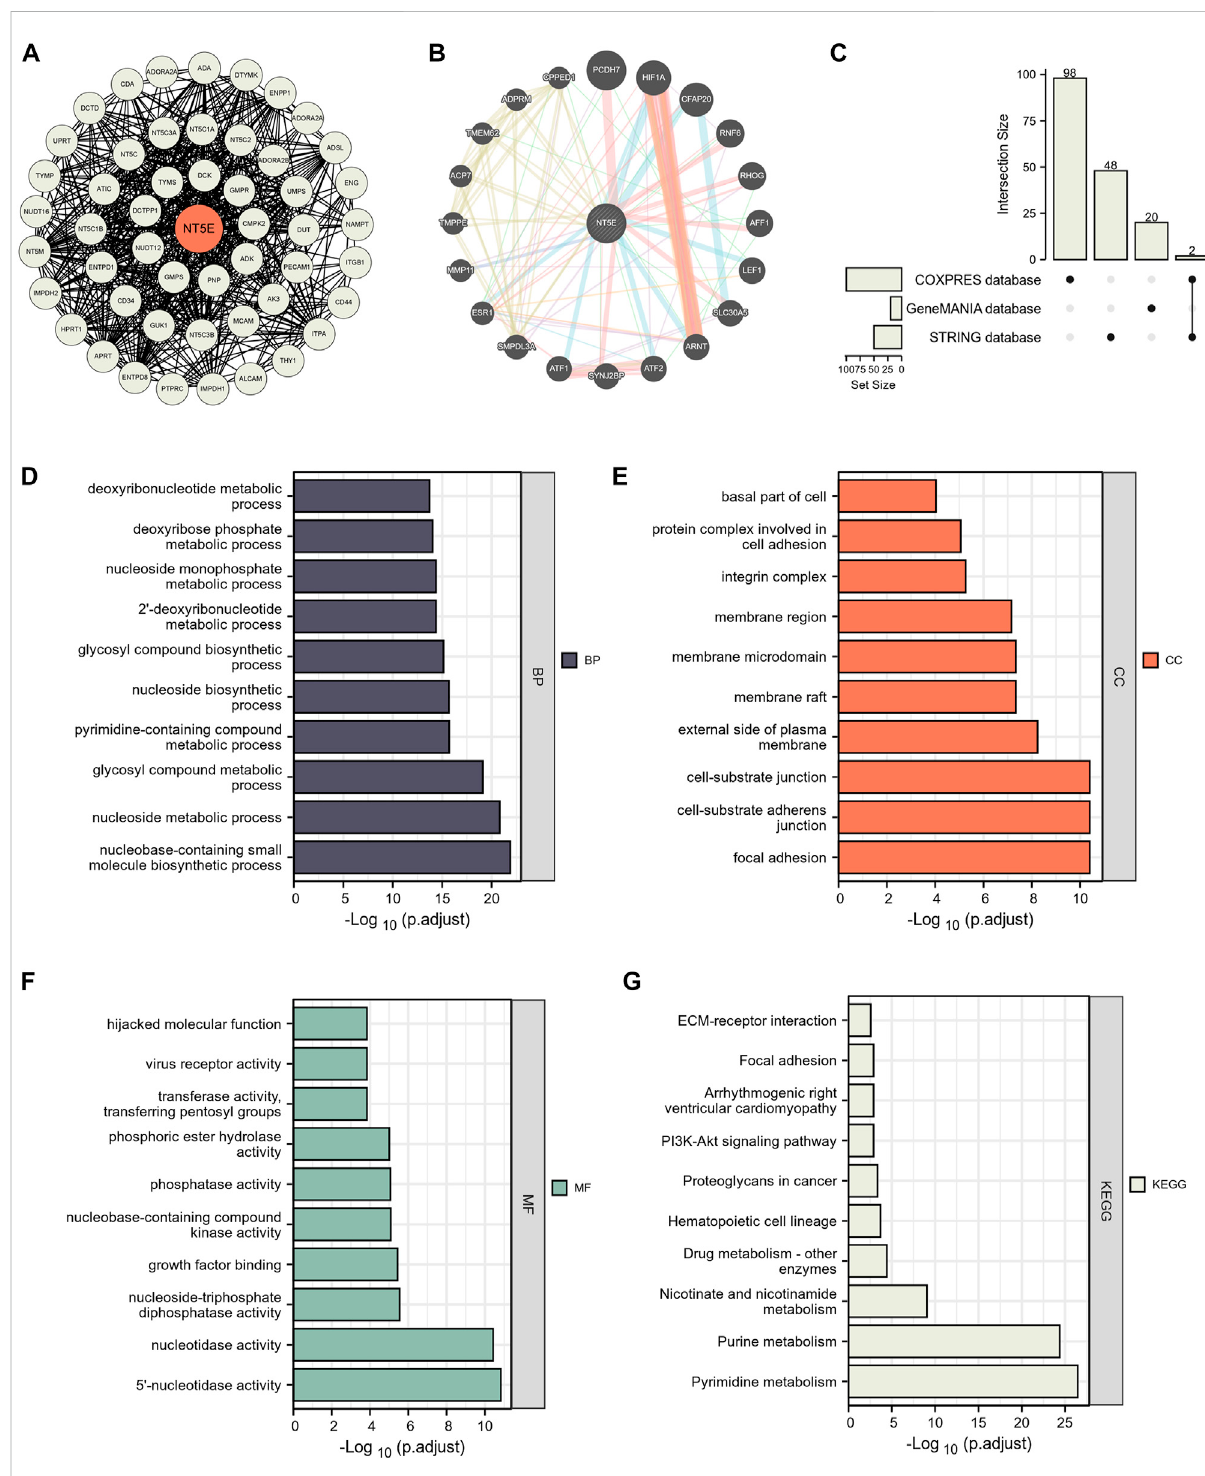
FIGURE 4 NT5E-related gene enrichment analysis. (A) We obtained the available experimentally determined NT5E -binding proteins using the STRING database. (B) WeusedtheGeneMANIAwebsitetogetthe20genesmostcloselyrelatedtoNT5E. (C) 168NT5Erelatedmoleculeswereselectedfrom STRINGdatabase,GeneMANIAdatabaseandCOXPRESdb. (D – F) Thebiologicalprocess (D) ,cellcomponents (E) ,andmolecularfunction (F) involved in NT5E in GO enrichment analyses. (G) the KEGG pathways enrichment